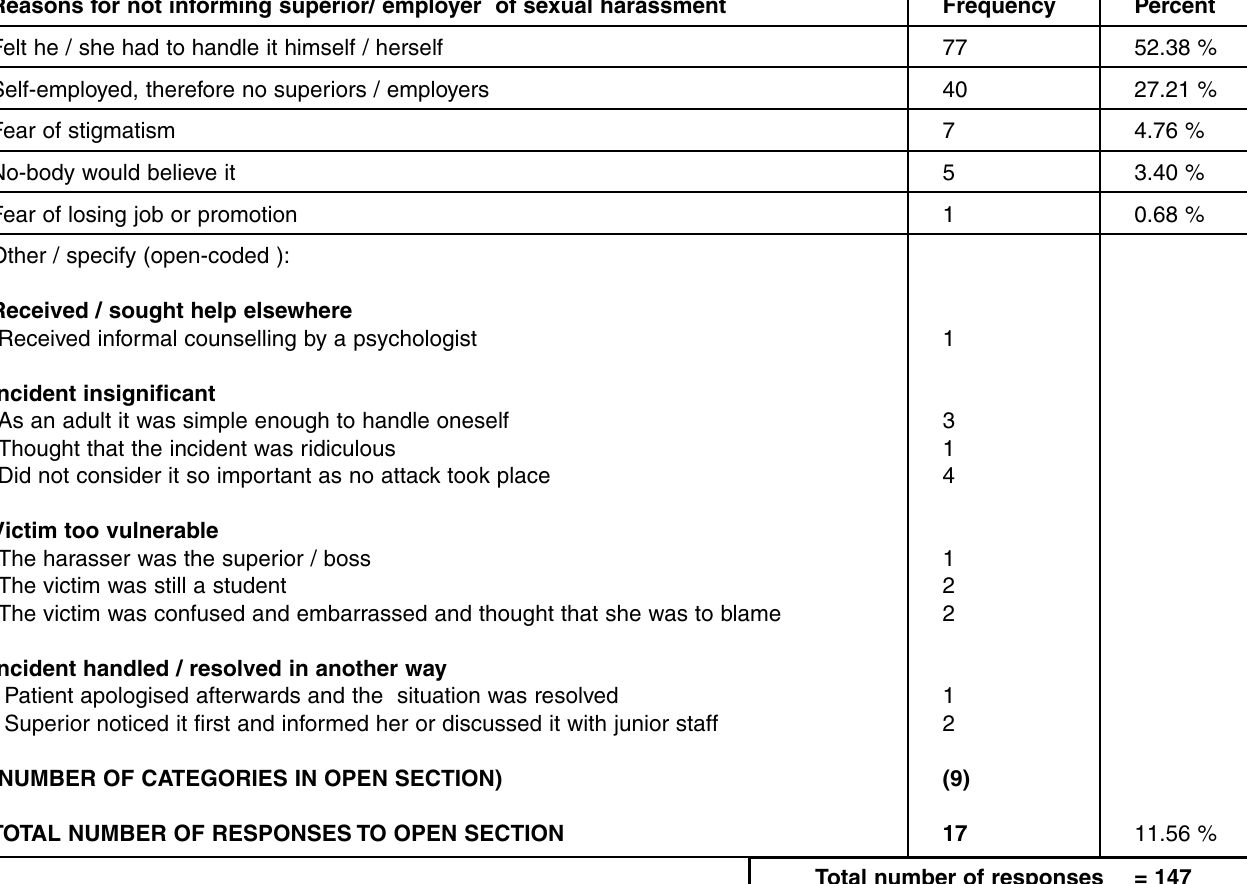
Table 2: Reasons why respondents did not inform superior/employer of sexual harassment Reasons for not informing superior/ employer of sexual harassment Frequency